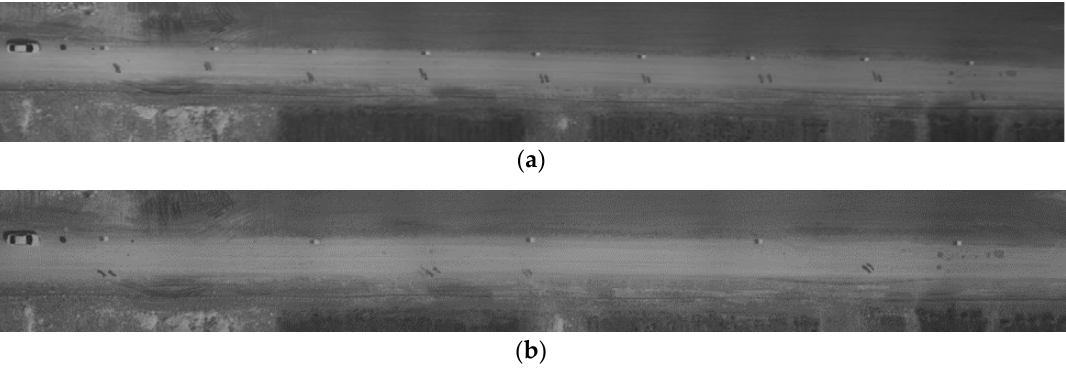
Figure 9. View of the reflectance reference panels moved in succession along the farm road for every waypoint ( a ) and only odd numbered waypoints ( b ).